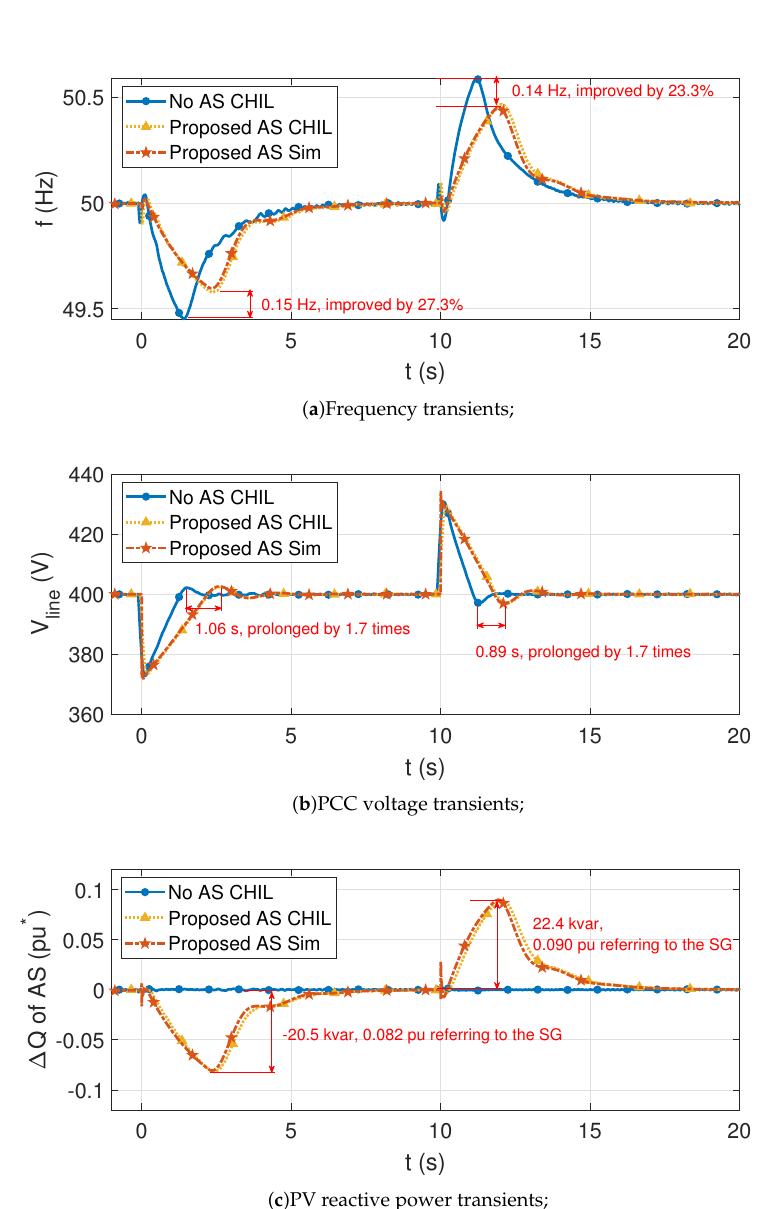
Figure 16. Dynamic performances of the systems with (yellow) and without (blue) ancillary service in CHIL versus the ancillary service test results in offline simulation (red). ∗ pu values are obtained according to the base values of the synchronous generation system in Table